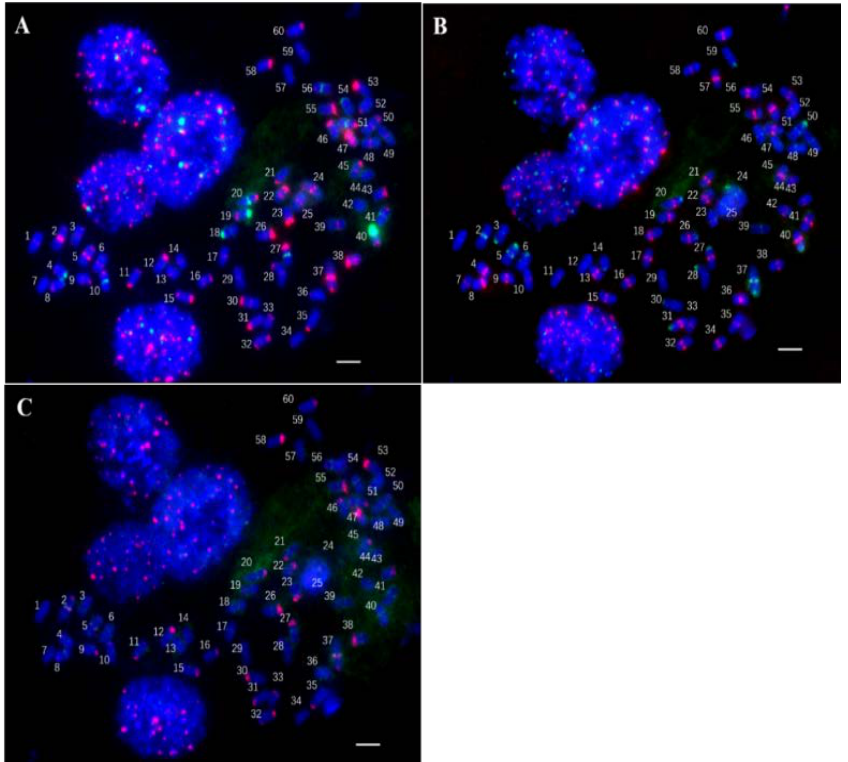
Figure 7. The result of three repeated FISH. ( A ): The first round of FISH results; ( B ): The second round of FISH results; ( C ): The third round of FISH results. Scale bars = 5 μm.